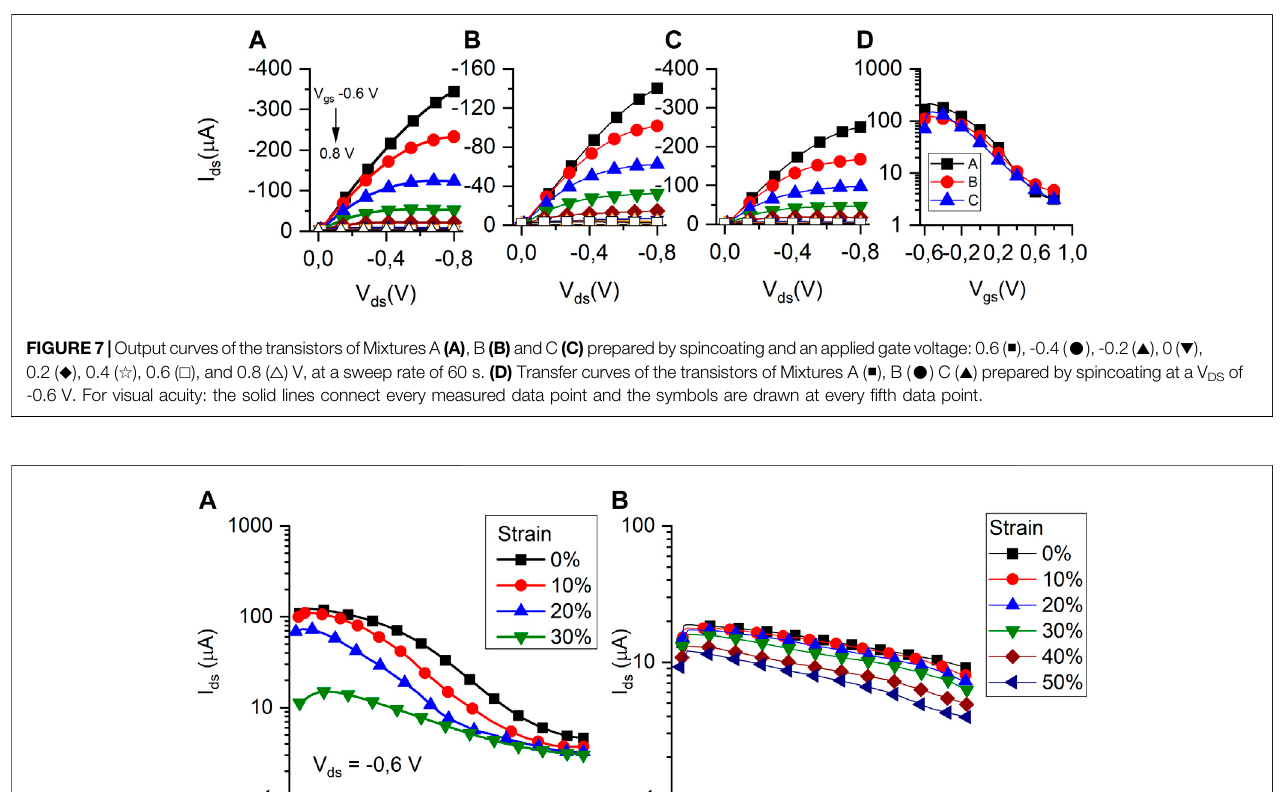
Frontiers in Physics |